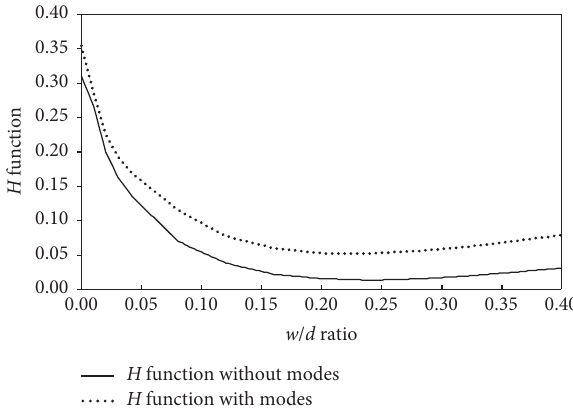
Figure 8: Target function H for the w / d ratio ranging between 0 and Table 7: MAC matrix (%) for w / d � 0.24.